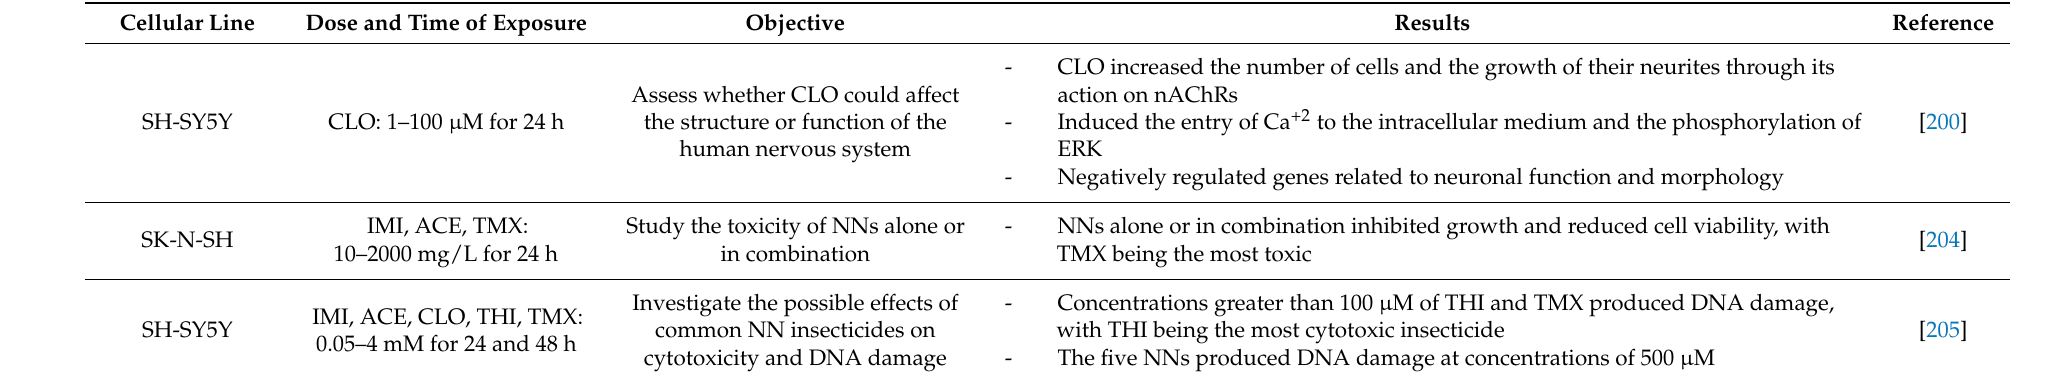
Table 3. Effects of neonicotinoid pesticides in human cells observed in vitro.